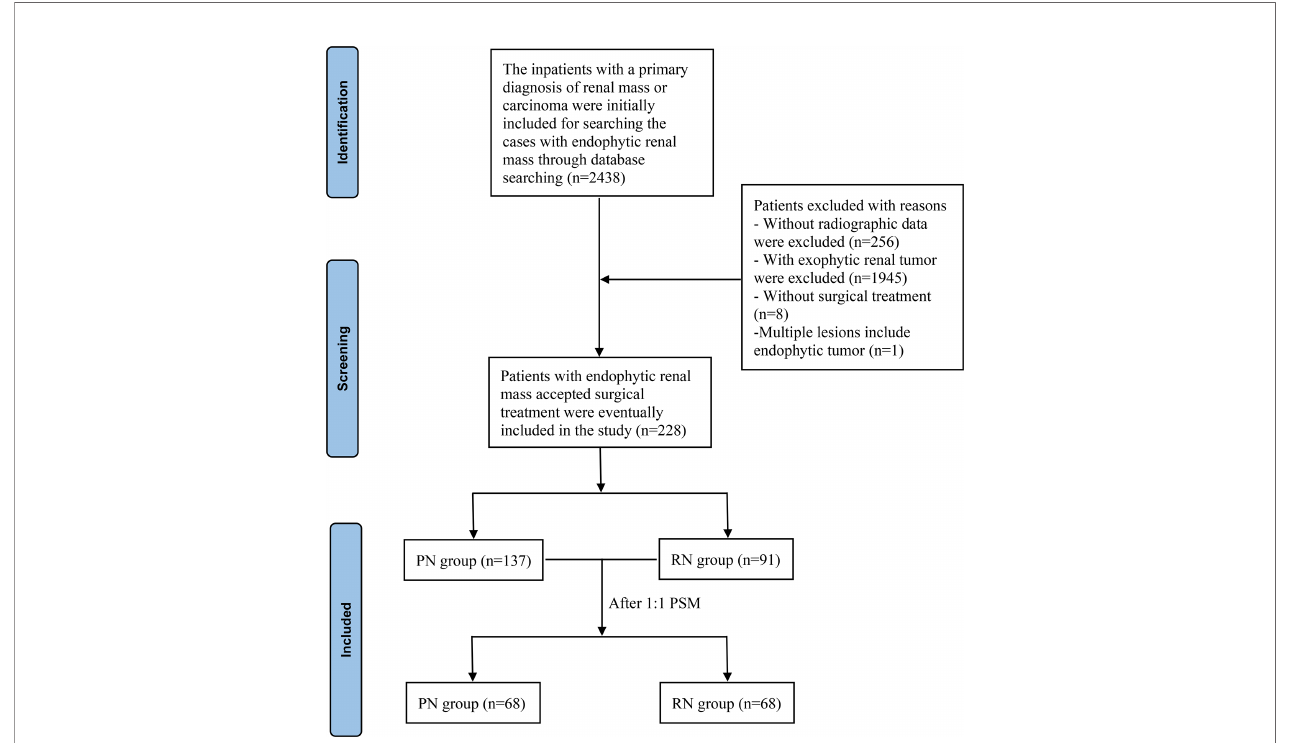
FIGURE 1 | Flow chart for inclusion of patients. PN, partial nephrectomy; RN, radical